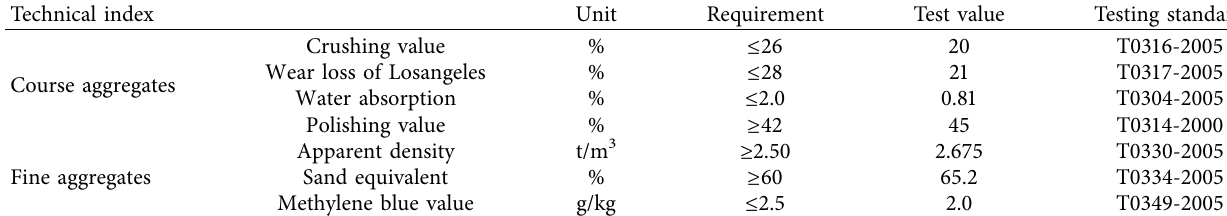
Table 2: Basic indexes of aggregates.